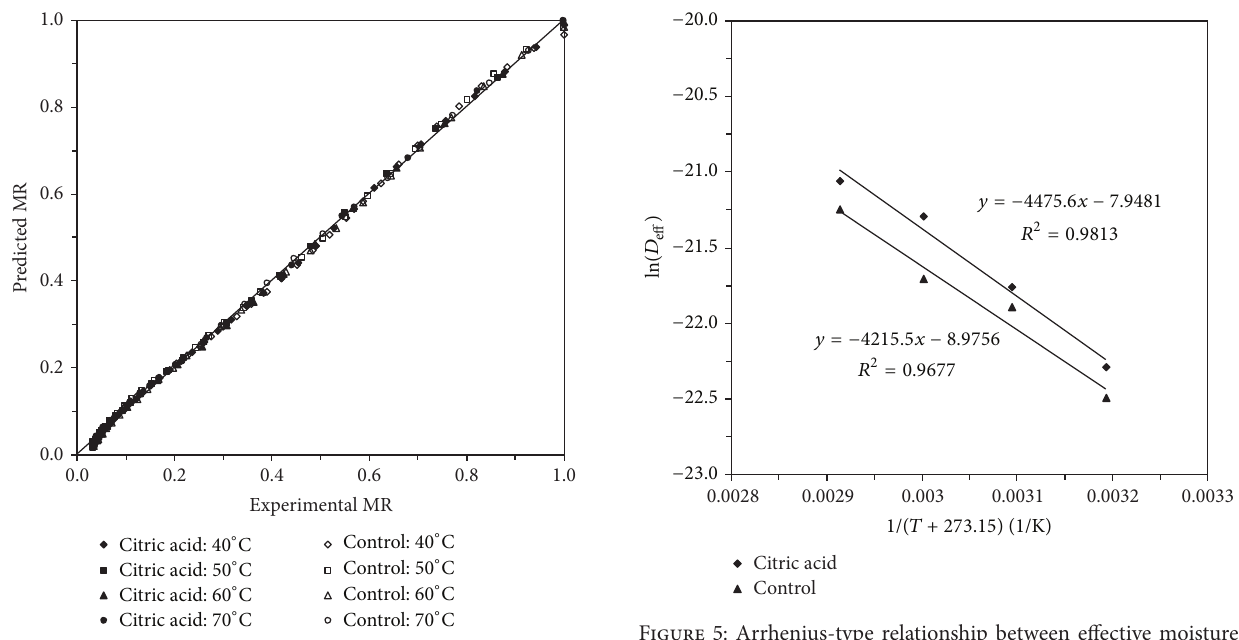
Figure 3: Comparison of experimental and predicted moistureratio values using logarithmic model.